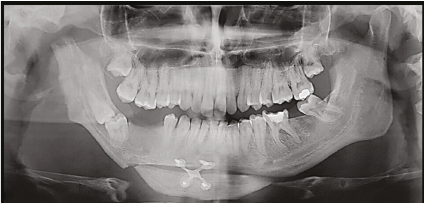
Figure 12: Panoramic radiography after seven days emphasizing the stable internal fi xation of the chin and bone gap on the right side of the TMJ